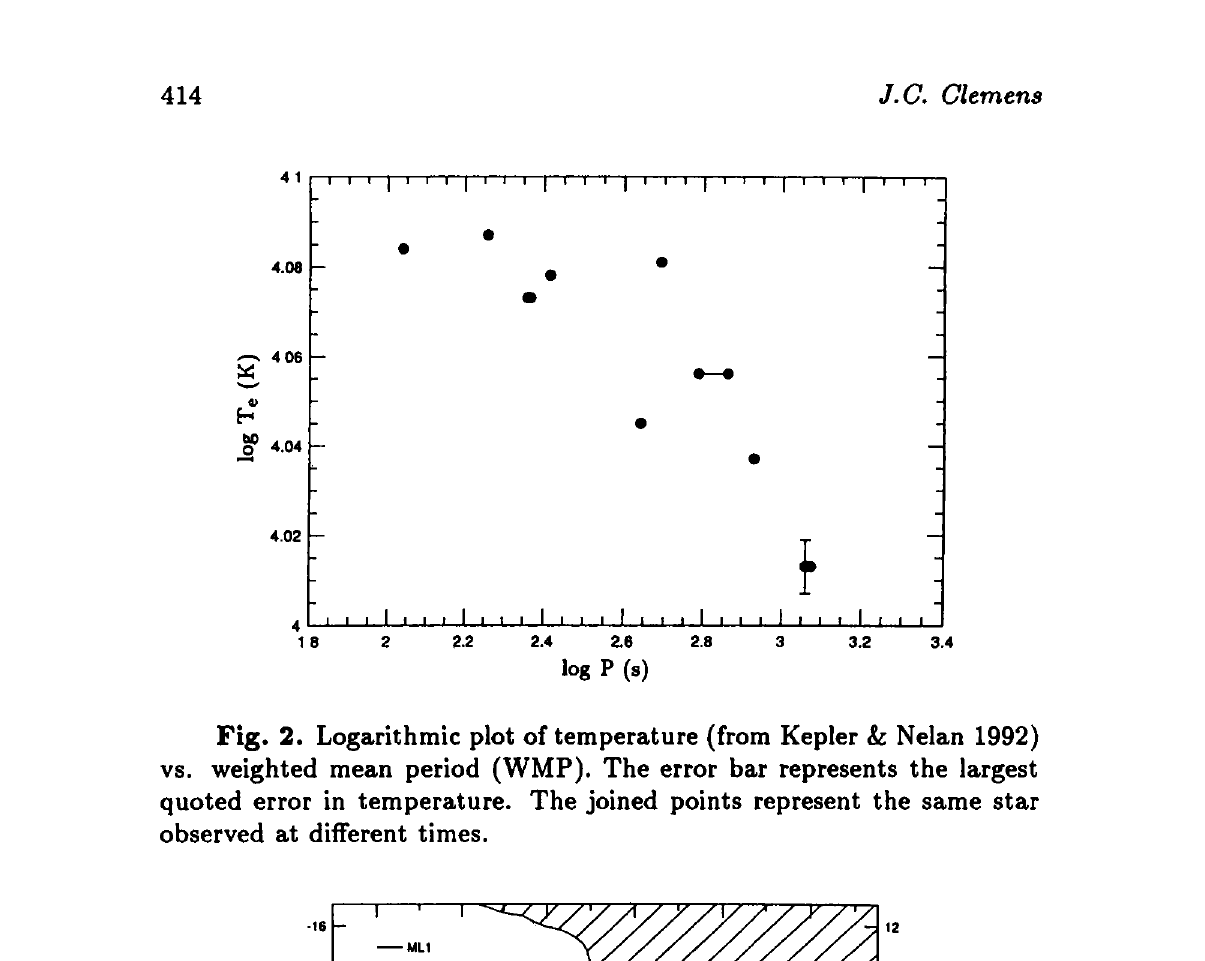
Fig. 2. Logarithmic plot of temperature (from Kepler & Nelan 1992) vs. weighted mean period (WMP). The error bar represents the largest quoted error in temperature. The joined points represent the same star observed at different times.